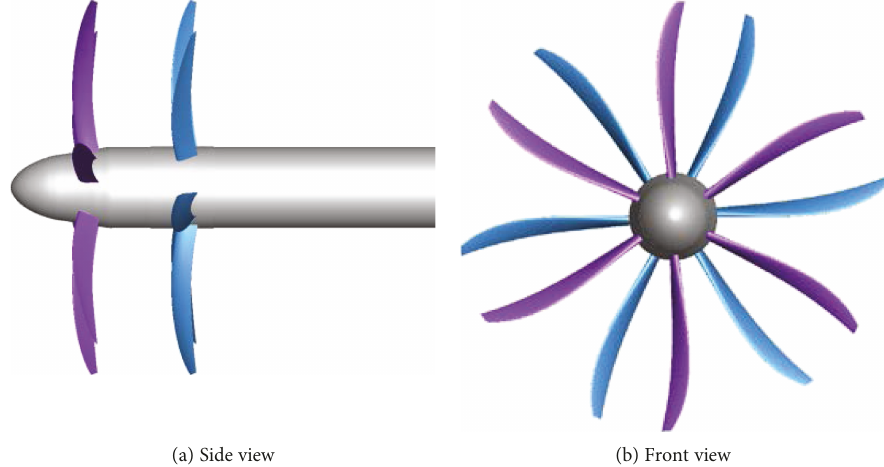
Figure 8: CROR numerical con fi guration and geometric layout.